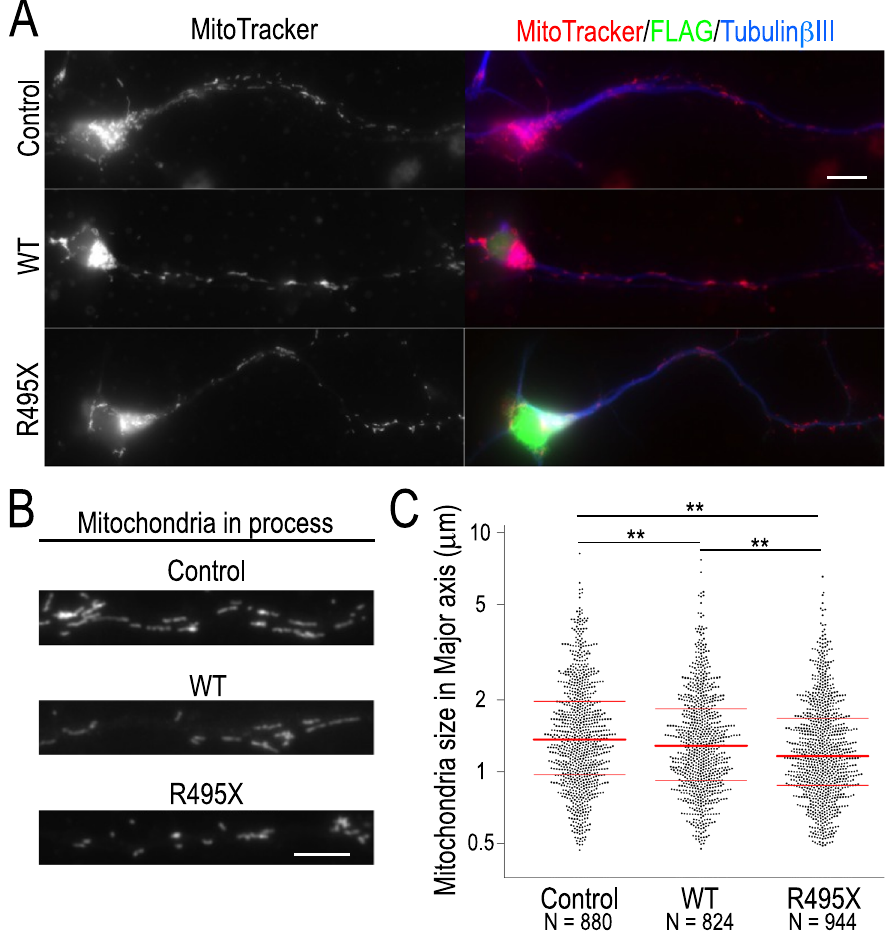
Figure 5. Mitochondria size for control, WT- and R495X-expressing neurons. ( A ) Images of mitochondria stained with MitoTracker (left) and merged images stained with anti-FLAG antibody (green), anti-Tubulin β III (blue) and MitoTracker (red) (right) for control (top), WT- (middle) and R495X-expressing neurons (bottom). Scale bar, 10 μ m. ( B ) Magnified images of MitoTracker stained neuronal processes for control (top), WT- (middle) and R495X-expressing neurons (bottom). Scale bar, 5 μ m. ( C ) Beeswarm plot for mitochondria major-axis length in control, WT- and R495X-expressing neurons. The number of analyzed mitochondria is indicated at the bottom. Red lines indicate the median, 25th and 75th percentiles. p < 0.0001, one-way ANOVA. ** p < 0.01, post Tukey’s HSD